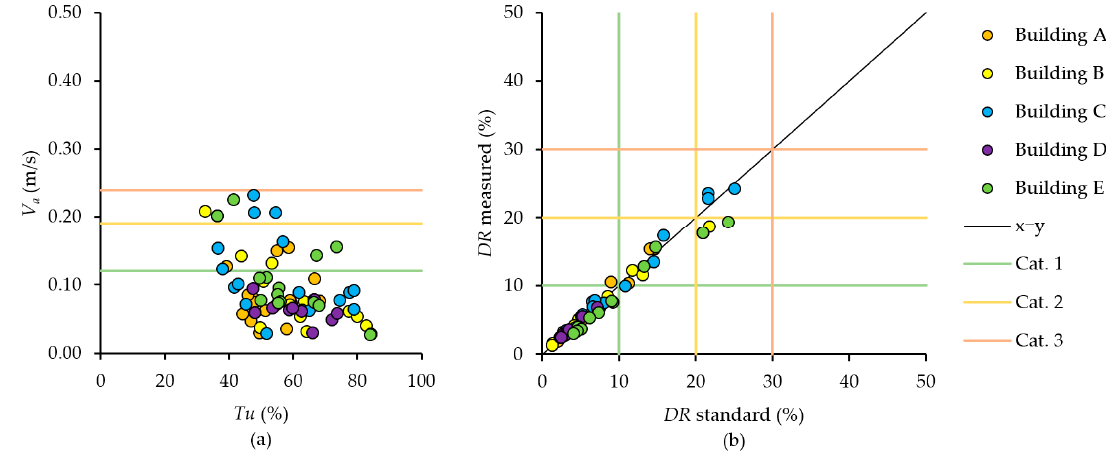
Figure 11. Air velocity and turbulence intensity results according to maximum air velocity categories I–III in summer ( a ); Draught rate correlation in measured and standard-based [54] conditions according to draught rate categories I–III ( b ).